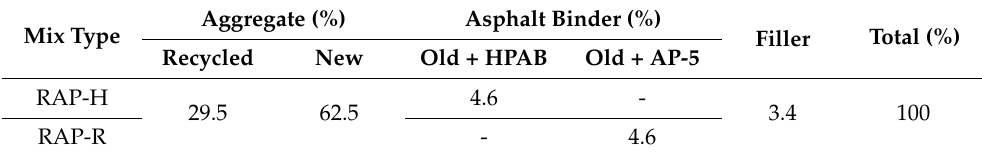
Table 6. Mix Design of reclaimed asphalt mixture. Table 7. Standard reference values for recycled asphalt mixtures.